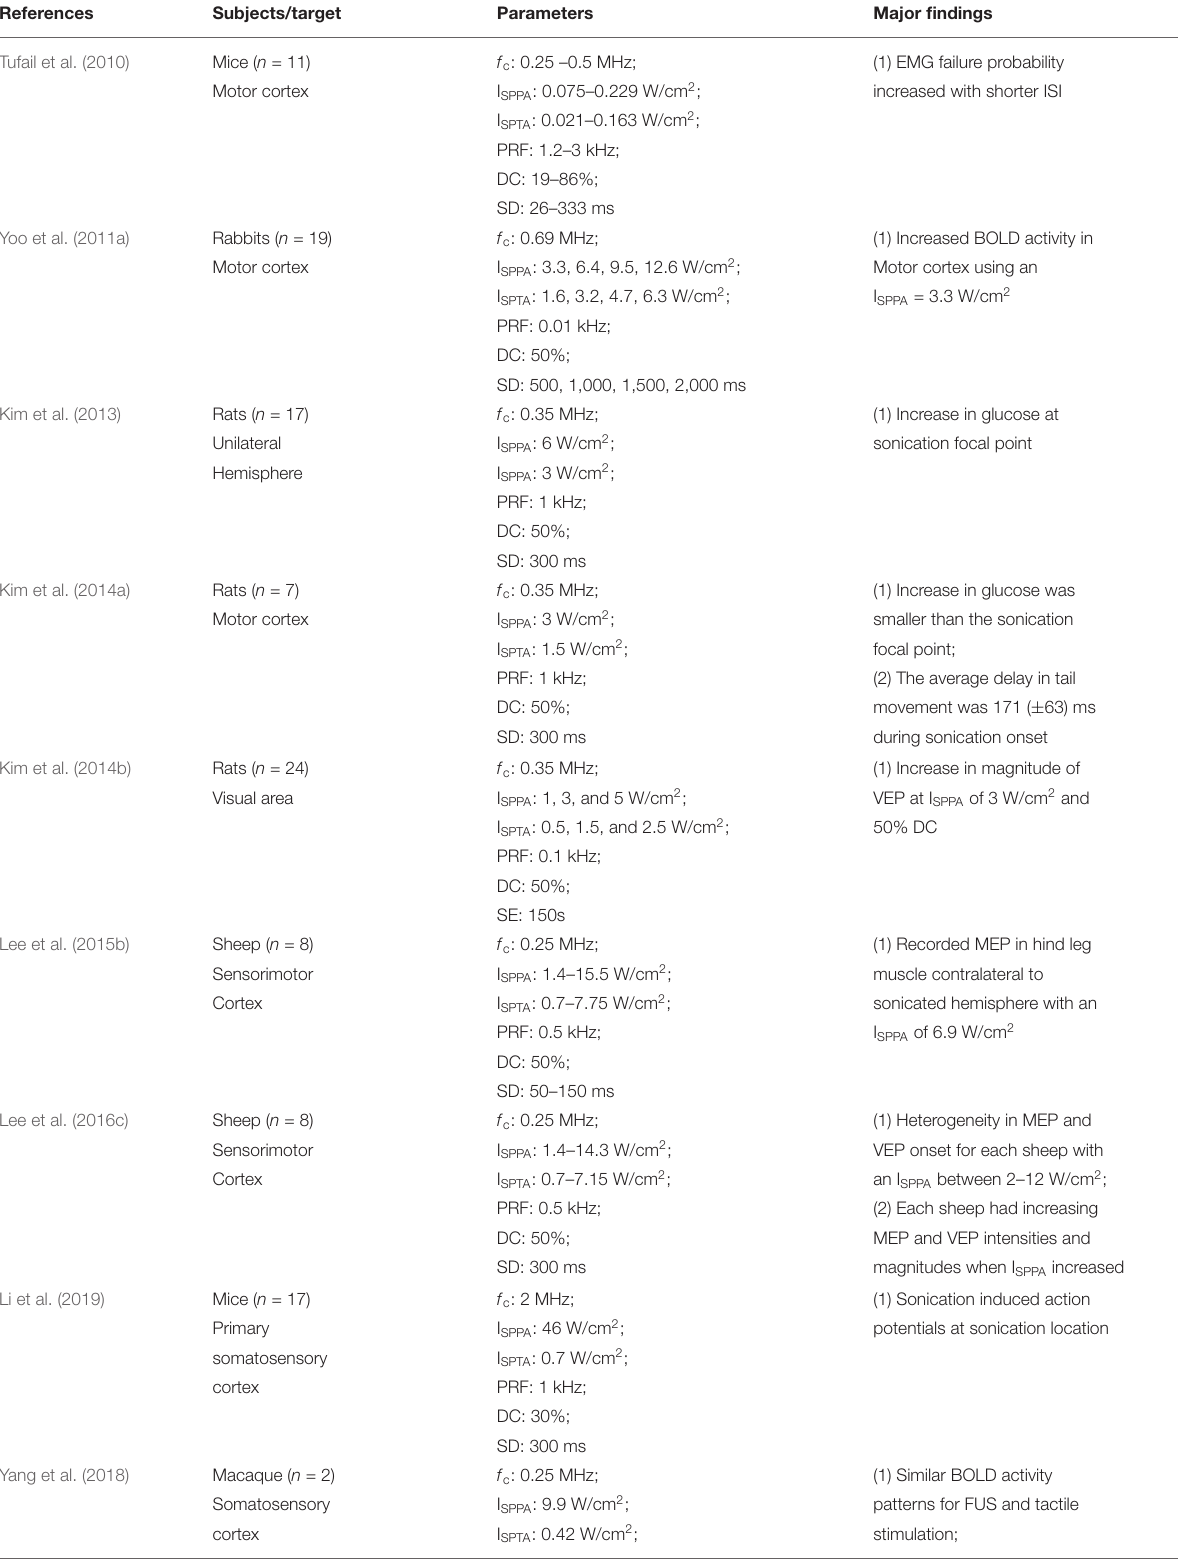
TABLE 1 | Excitatory electrophysiology/neuroimaging findings for animals and